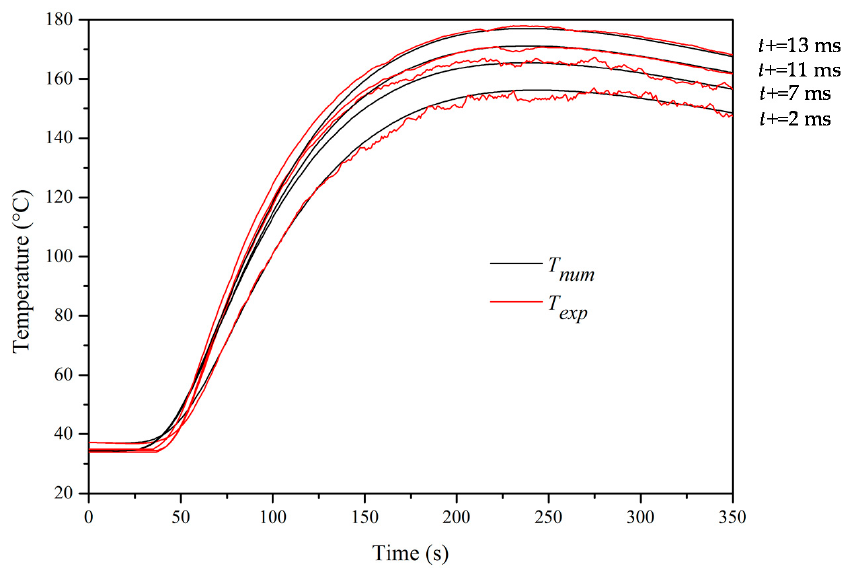
Figure 4. Evolution of the experimental and numerical temperatures for different t + conditions.